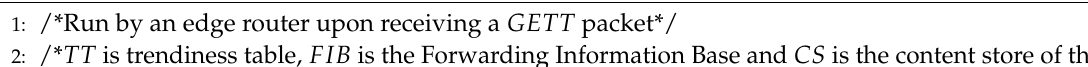
Algorithm 2 Cache_trendy_data( TT , FIB , D , CS